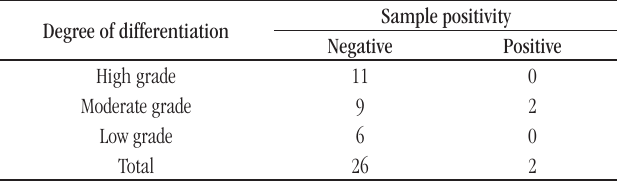
taBLE 1 − Association between result of peritoneal lavage and degree of tumor differentiation of endometrial carcinoma ( n = 28) Degree of